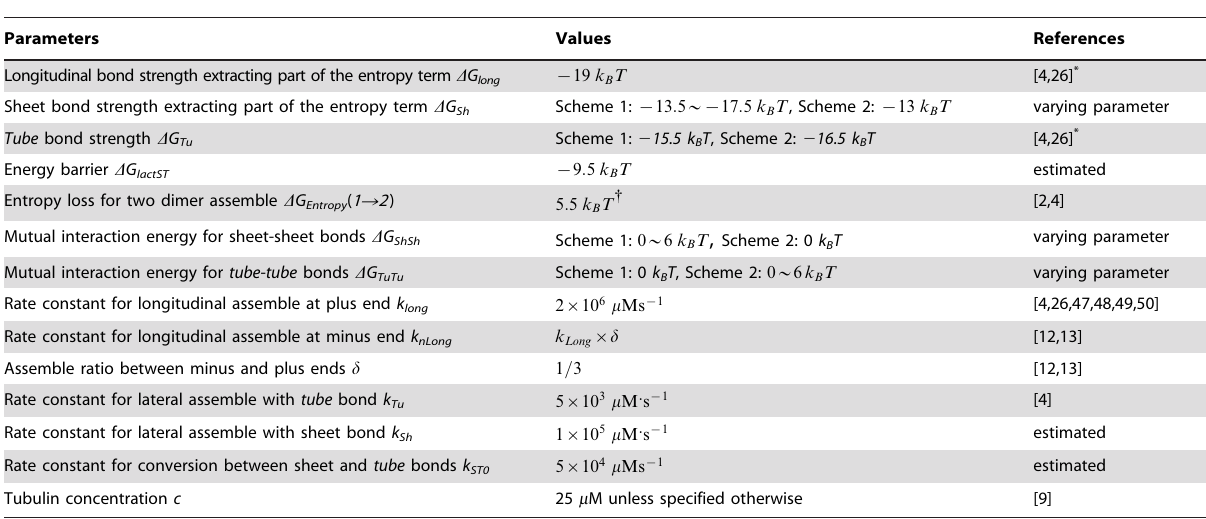
Table 1. Parameters used in the